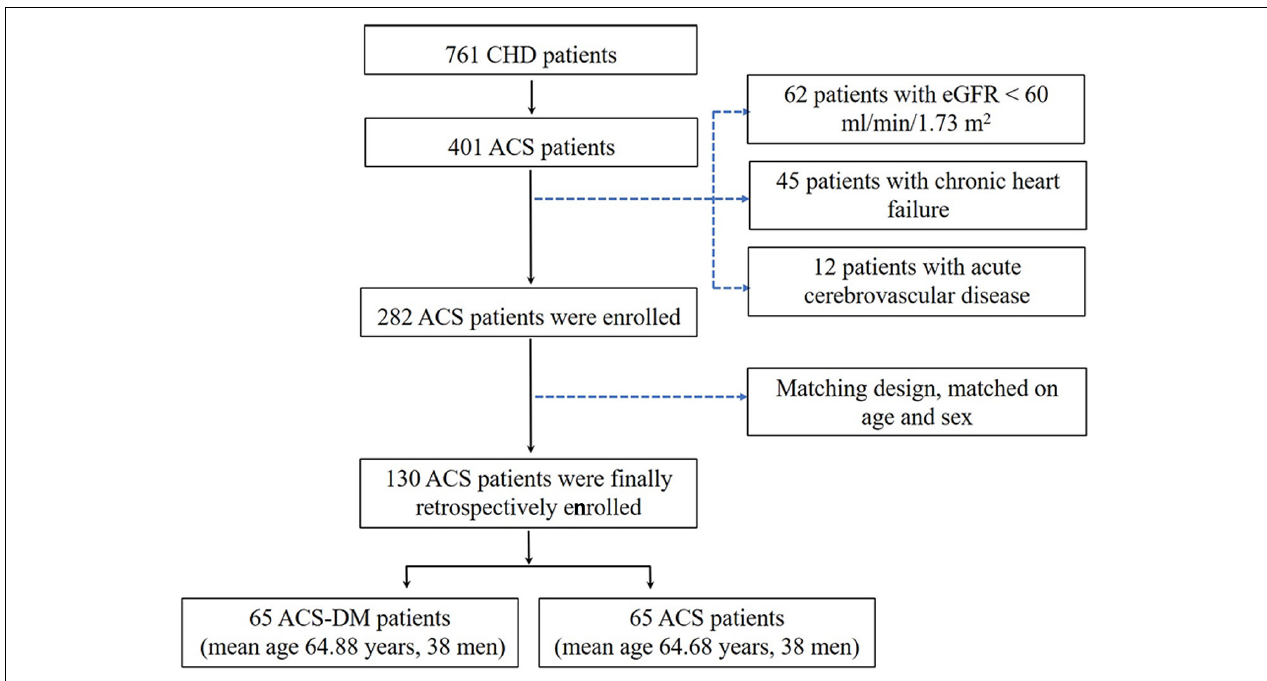
FIGURE 1 | Study frame diagram. ACS, acute coronary syndrome; CHD, coronary heart disease; eGFR, estimated glomerular filtration rate.